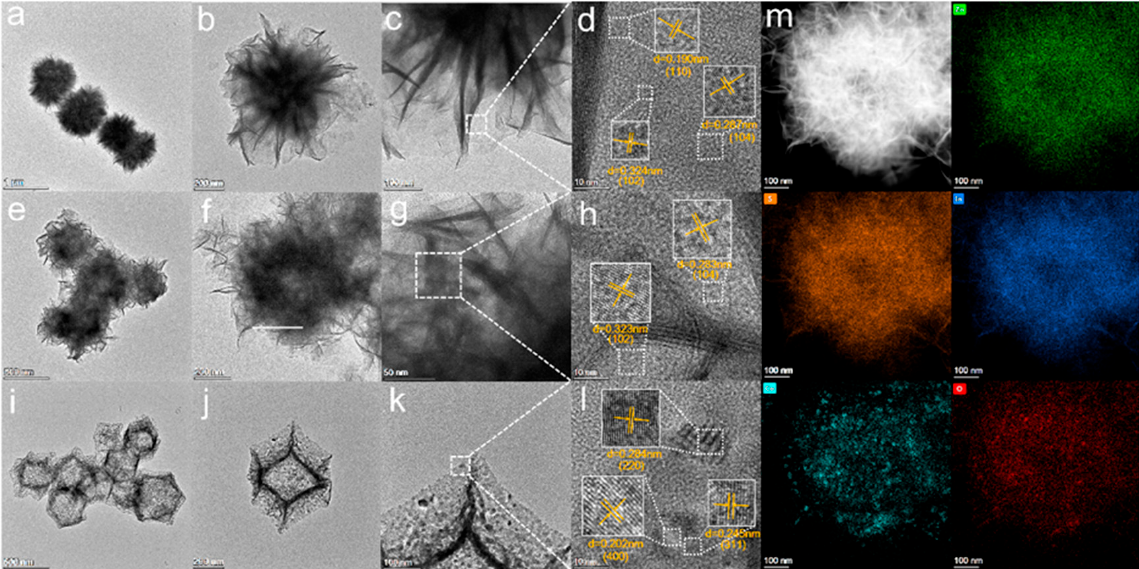
Figure 4. ( a – d ) STEM images of ZnIn 2 S 4 and its HRTEM images; ( e – h ) STEM images of Co 3 O 4 (20)@ZIS and its HRTEM images; ( i – l ) STEM images of Co 3 O 4 and its HRTEM images; ( m ) HAADF-STEM images of Co 3 O 4 (20)@ZIS and the corresponding elemental distribution images.